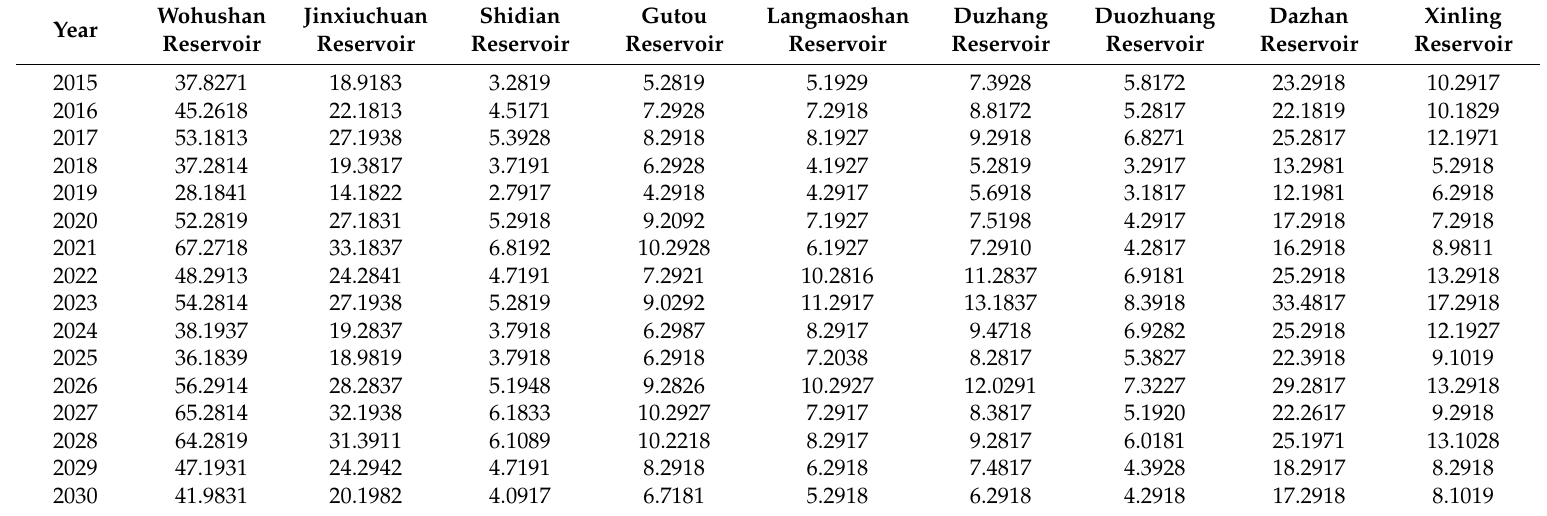
Table 3. Integrated prediction for reservoir runoff in Jinan (units: million m 3